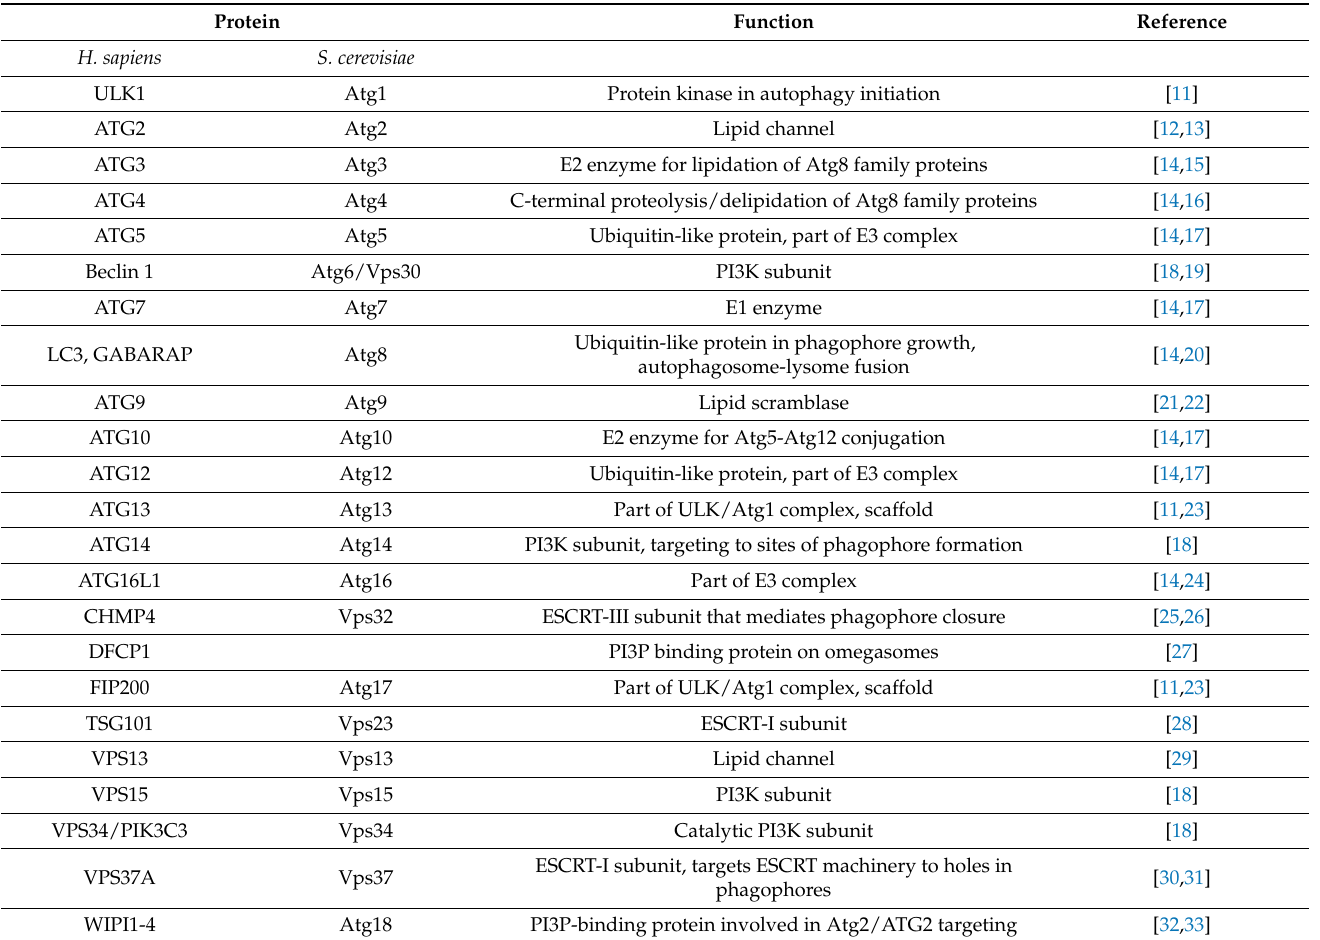
Table 1. Proteins involved in autophagosome biogenesis. For H.sapiens proteins, isoforms have mostly been omitted from the